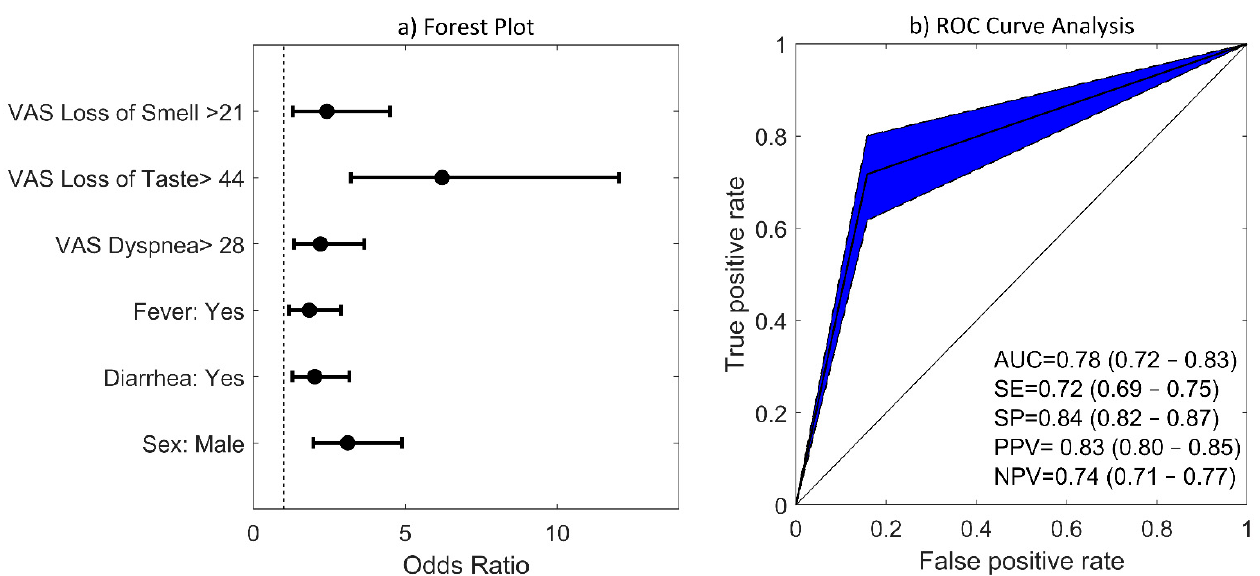
Figure 3. Step-wise logistic regression model obtained under BIC criterion: ( a ) Forest plots for association between